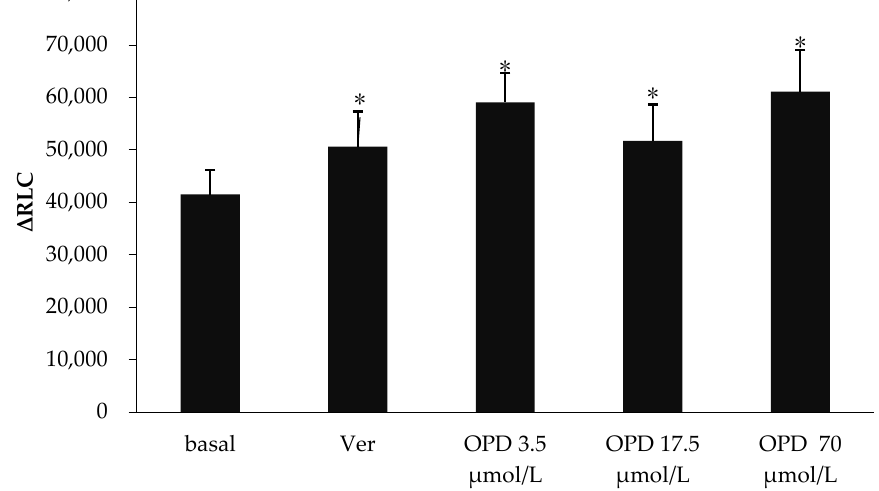
Figure 2. Effect of OPD modulating the activity of P-gp ATPase. Values are mean ± SD ( n = 5). Differs from Basal group: * p < 0.05.